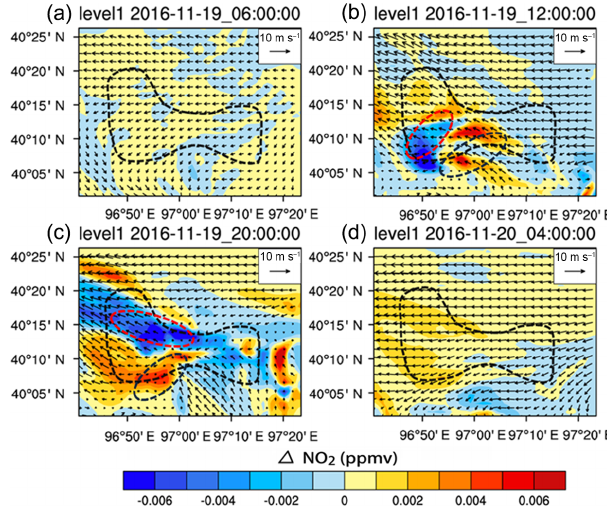
Figure 10. Same as Fig. 6 but for the concentration differences (cid:49)C between S3 model run and the control run (S1), given by S3 −